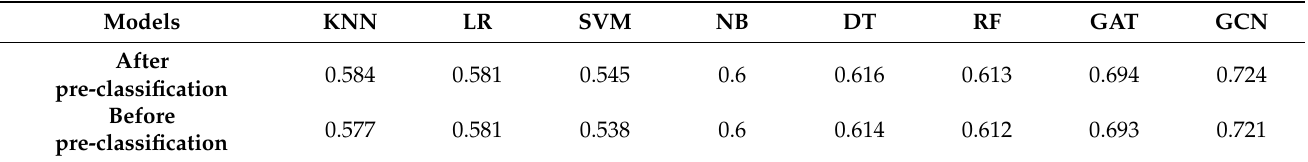
Table 11. Comparison of accuracy of different models before and after pre-classification of meteoro- logical factor